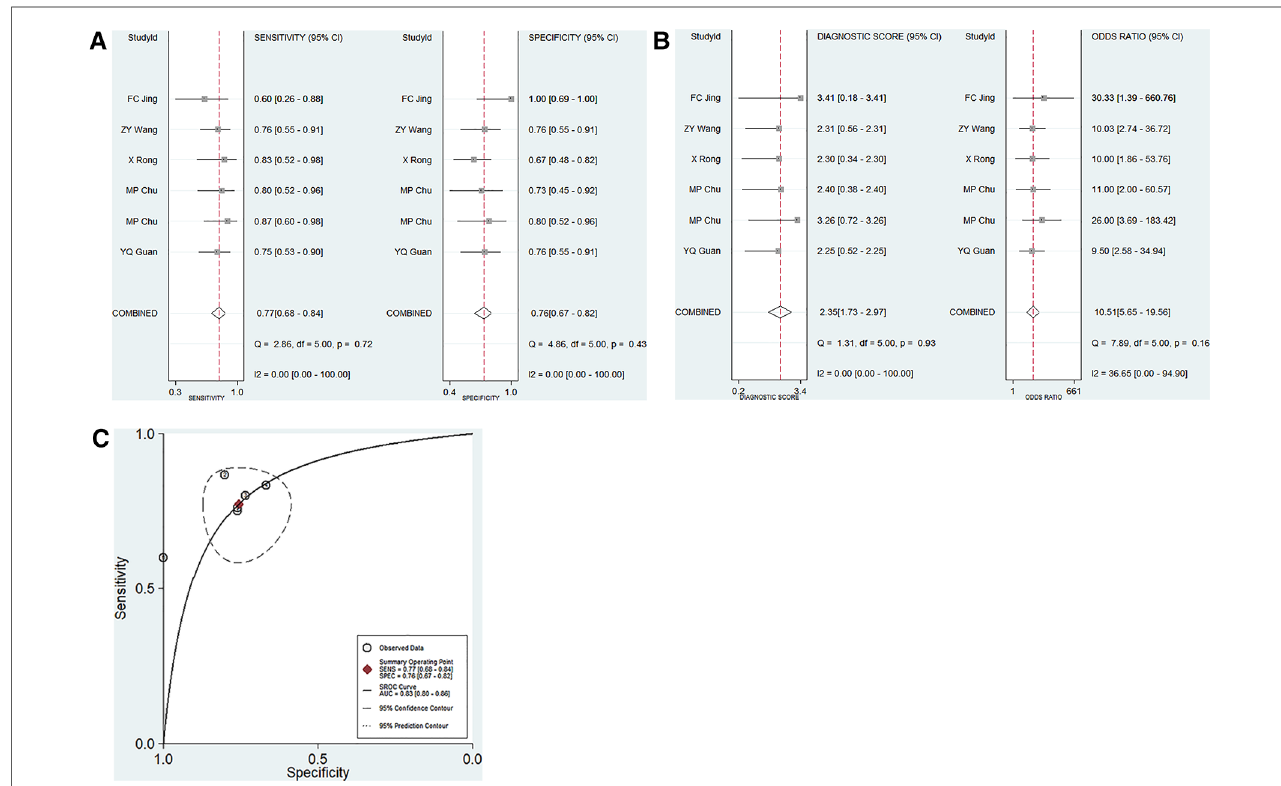
FIGURE 3 Pooled results of the studies on overall ncRNAs used in the diagnosis for KD-CAL among 6 studies included in the meta-analysis. ( A ) Pooled sensitivity and speci fi city; ( B ) Pooled DOR; ( C ) SROC.